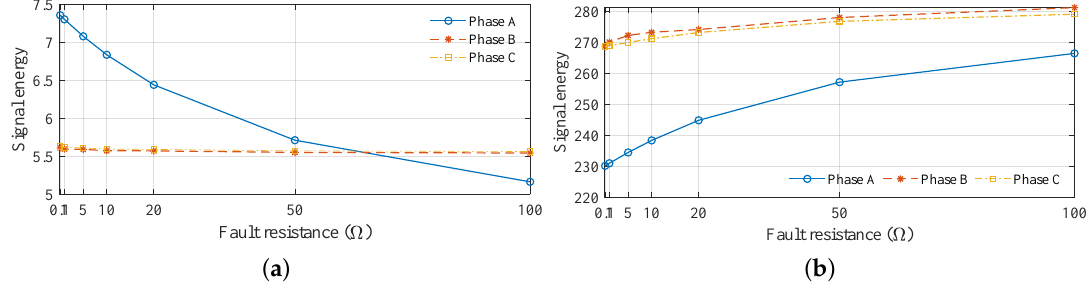
Figure 4. Variation of three phase ( a ) current and ( b ) voltage signal energy during the a-g fault with the fault resistance for the grid-tied radial mode